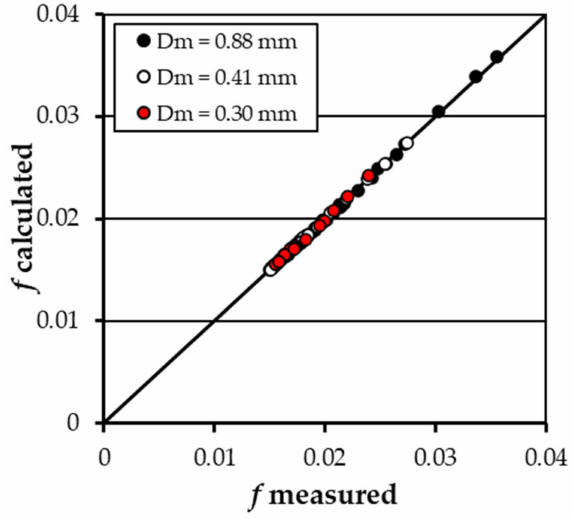
Figure 7. Comparison between the measured Darcy-Weisbach friction factor values, f m , and those calculated, f c , by Equation (3) with Γ f estimated by Equations (12) and (13) with the coefficients listed in Table